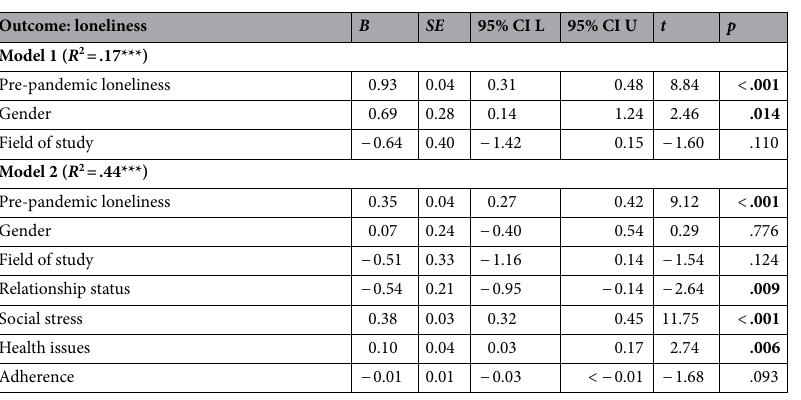
Table 5. Linear regressions of associations between loneliness and gender, field of study, relationship status (model 1), and social stress due to the pandemic, health issues due to the pandemic, and adherence to pandemic containment measures (model 2). Bold values are statistically